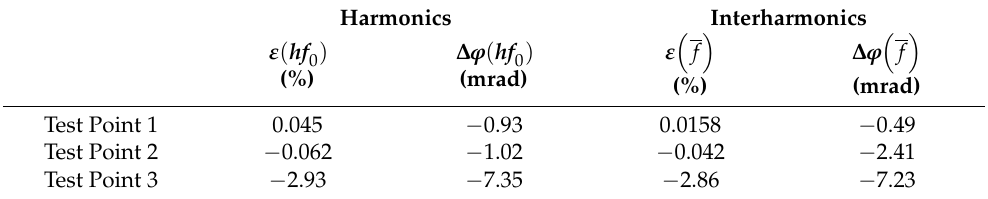
Table 11. Ratio and phase errors of VT in harmonics and interharmonic measurements.